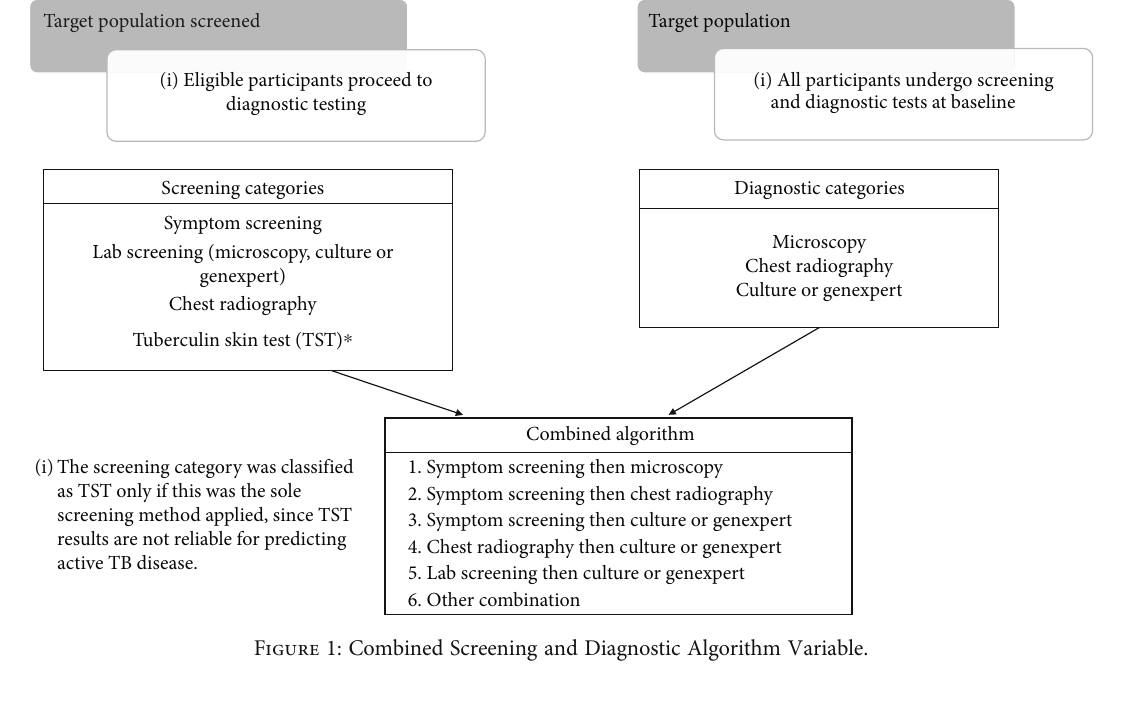
Figure 1: Combined Screening and Diagnostic Algorithm Variable.